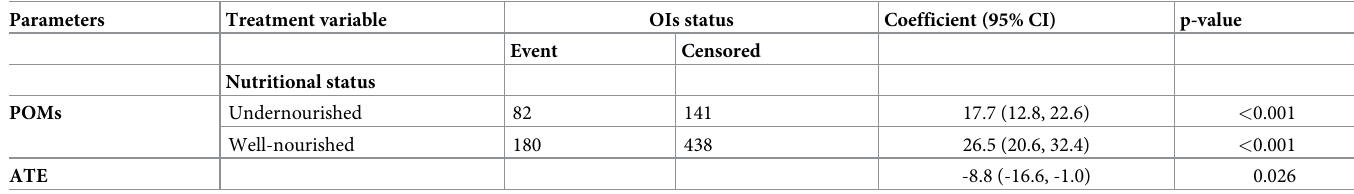
Table 4. The effect of undernutrition on the time to develop OIs in adults living with HIV on ART at Debre Markos Comprehensive Specialized Hospital, North- west Ethiopia.